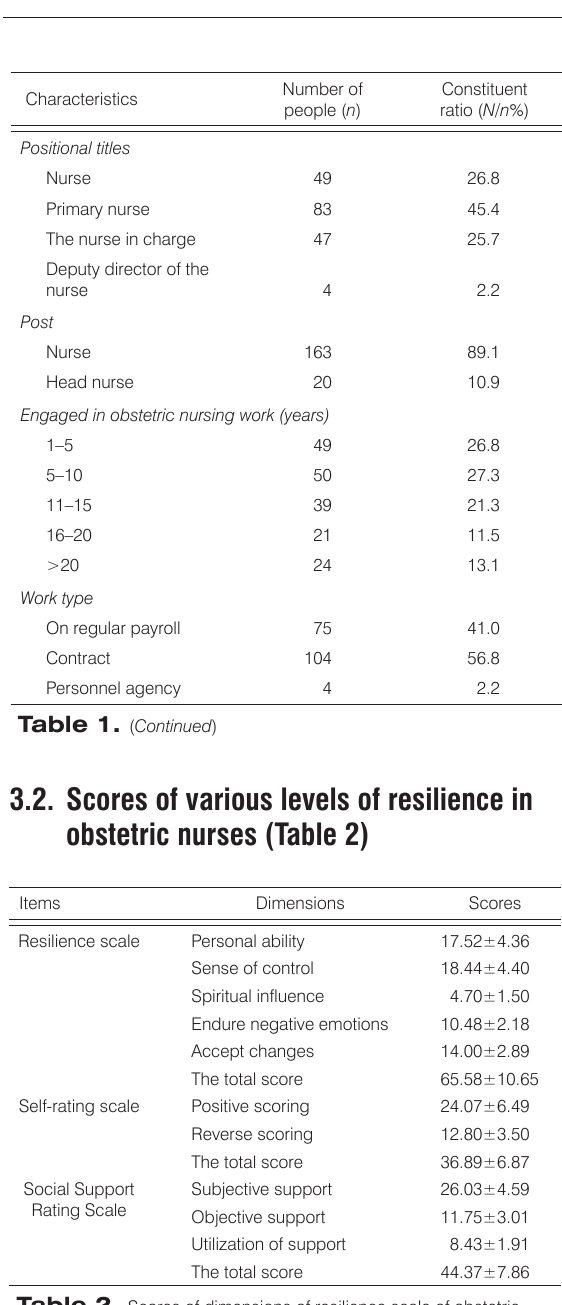
Table 2. Scores of dimensions of resilience scale of obstetric nurses (mean±SD).